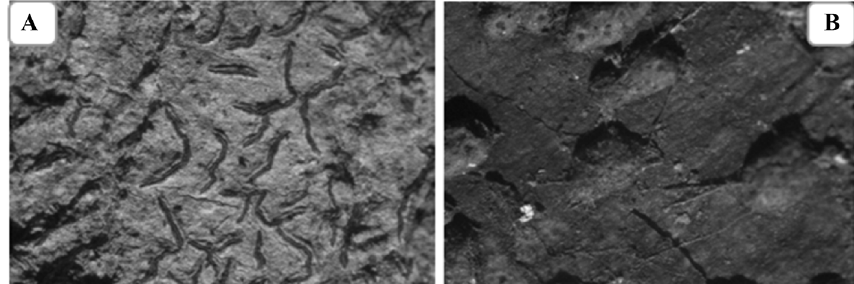
Fig. 2 Microscopic photograph of Lichen species A Phaeographis dendritica and B Trypethelium